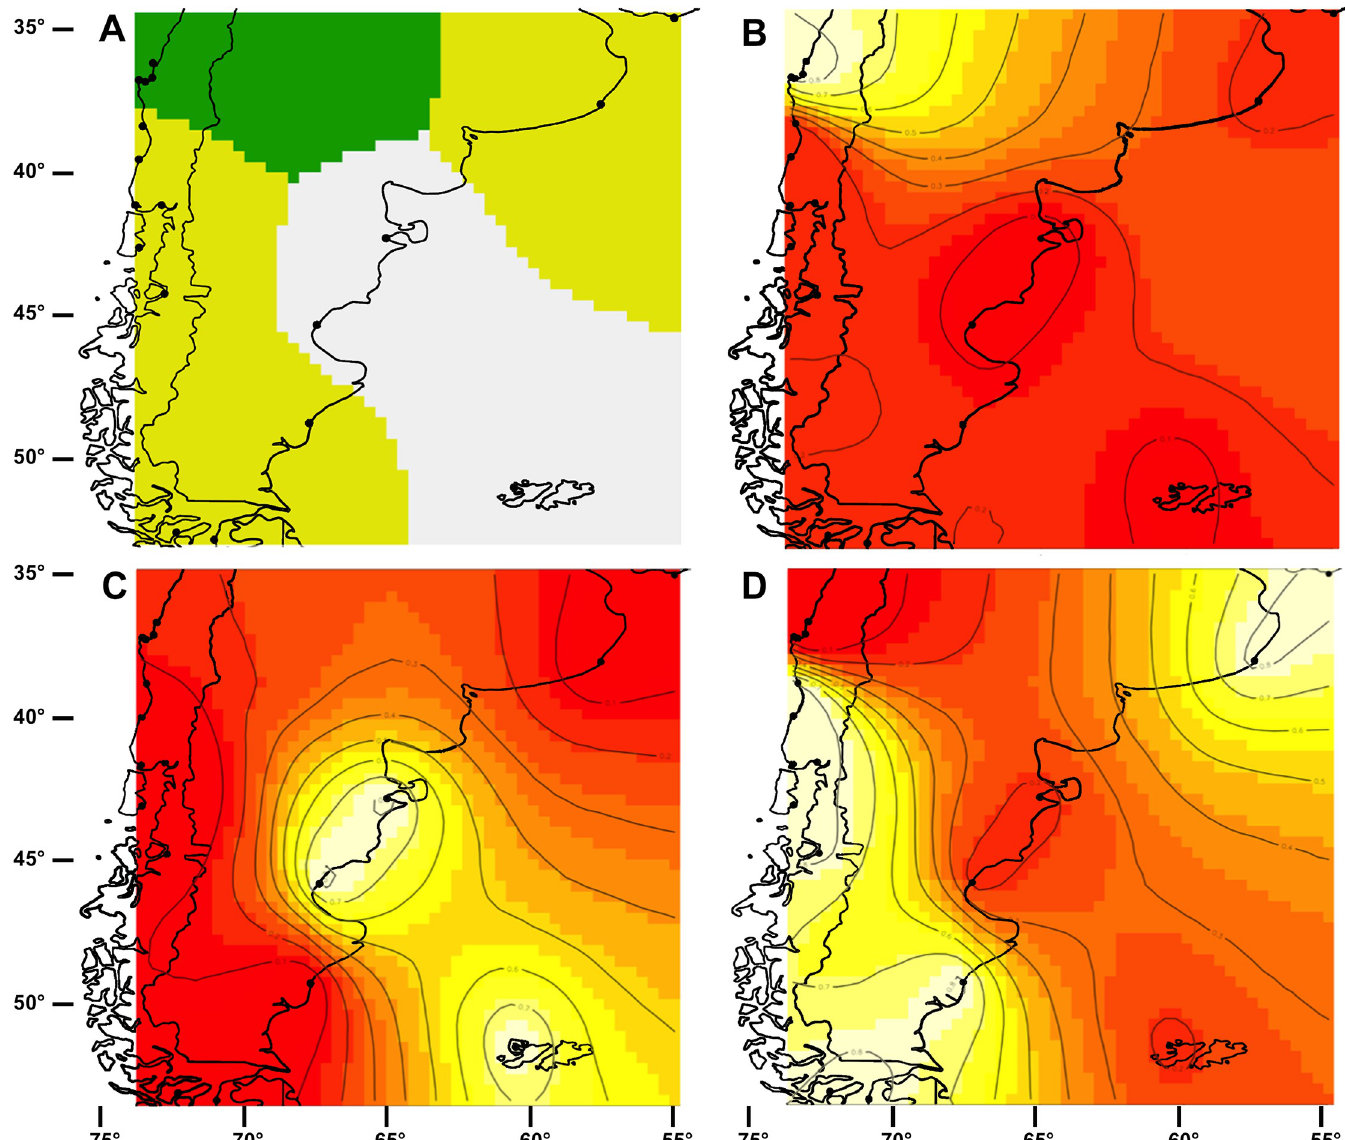
Fig 4. Geneland results for K = 3 groups using the spatial model with correlated allele frequencies (based on COI). (A) Map of estimated posterior probability of population membership (by posterior mode)–different colours represent distinct genetic groups; plots representing the assignment of pixels to: B) introduced Mytilus galloprovincialis in Chile, (C) mussels from the Atlantic coast of South America, and (D) M . chilensis mussels from the Pacific and southern Atlantic coasts of South America. The highest membership values are in white and light yellow and the contour lines indicate the spatial position of genetic discontinuities between